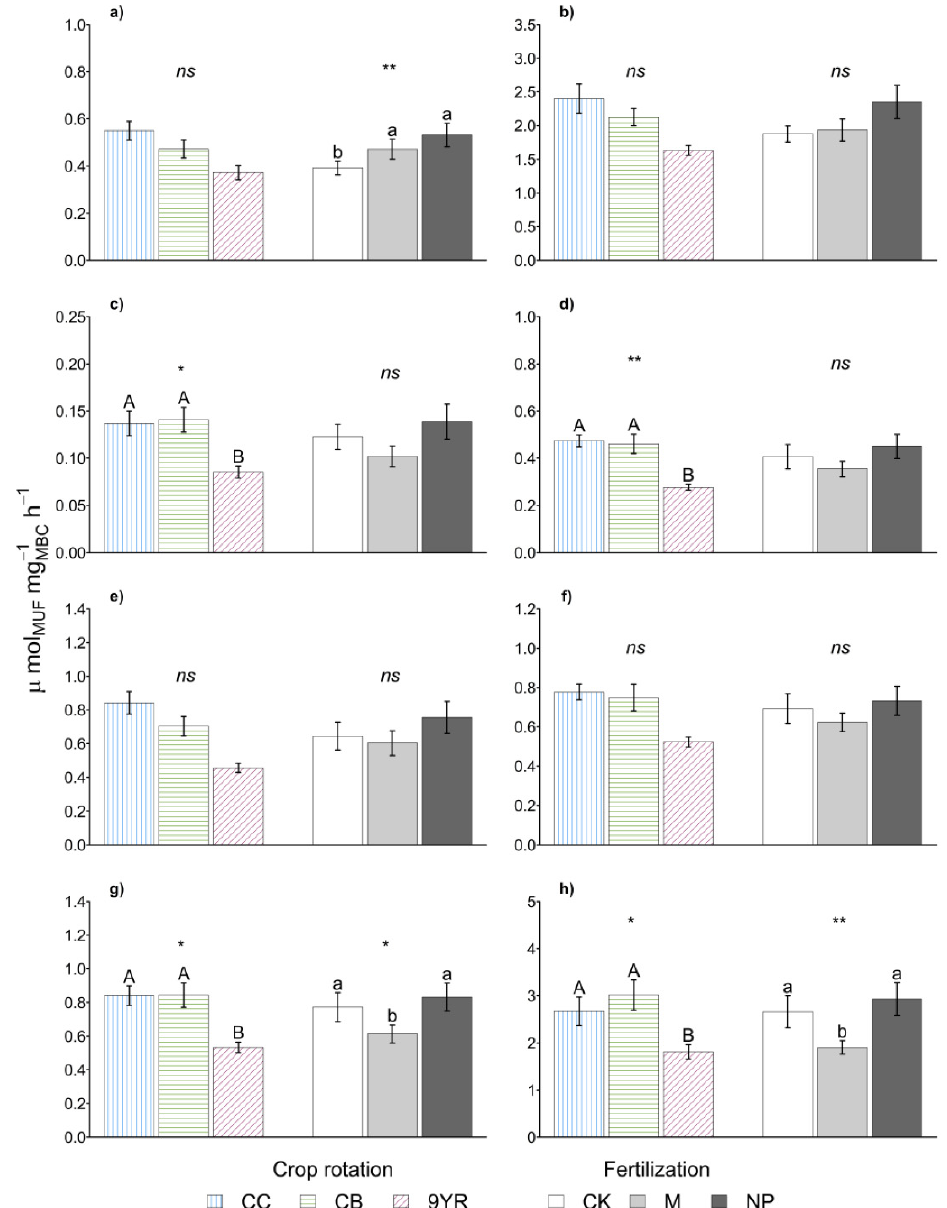
Figure 3. Marginal means of specific ( a ) β -cellobiosidase, ( b ) β -glucosidase, ( c ) α -glucosidase, ( d ) β -xylosidase, ( e ) N-acetyl- β -glucosaminidase, ( f ) arylsulfatase, ( g ) phosphodiesterase, ( h ) phosphomonoesterase soil enzymatic activities for rotation and fertilization effects. Error bars represent standard errors. Different upper-case and lower-case letters indicate significant differences ( p -value < 0.05), respectively, between rotation and between fertilization as determined by the Fisher’s LSD test. Statistical significance of the differences according to the ANOVA ( ns p < 0.05; * p ≤ 0.05; ** p ≤ 0.01; *** p ≤ 0.001).